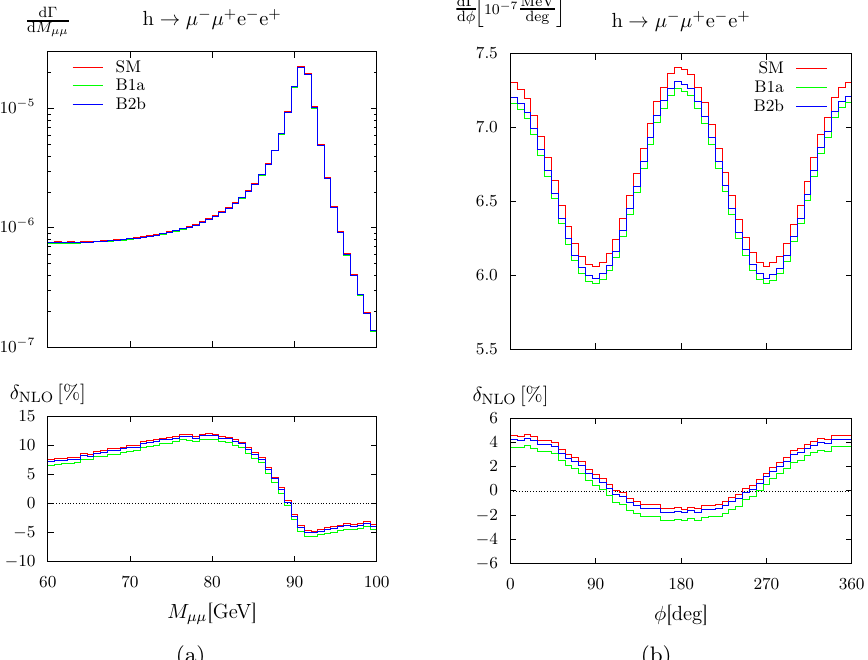
Figure 36 . Invariant-mass (a) and angular distributions (b) of the leptonic neutral-current decay h (cid:22) (cid:0) (cid:22) + e (cid:0) e + for the SM and the THDM scenarios B1a and B2b. The relative NLO corrections ! to the distributions are plotted in the lower panels.